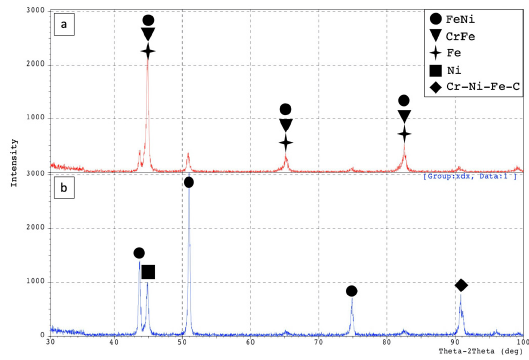
Figure 11. XRD of welds (a) without Ni powder (b) with Ni